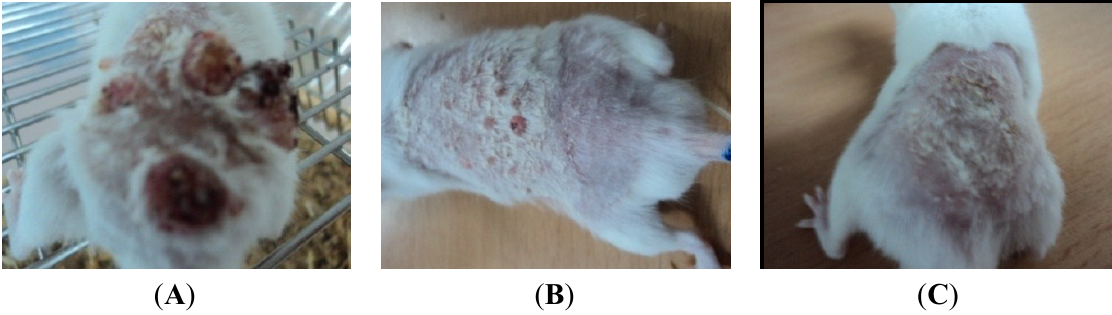
Figure 1. Rutin-induced reduction of tumor in “Swiss albino mice”: ( A ) Animal treated with water, DMBA and croton oil and observation was made at the last day of the experiment. ( B ) Animal treated with DMBA and croton oil as in ( A ) but with rutin infusion after the application of croton oil. ( C ) Animal treated with DMBA and croton oil as in ( B ) but with the increased concentration of rutin infusion.